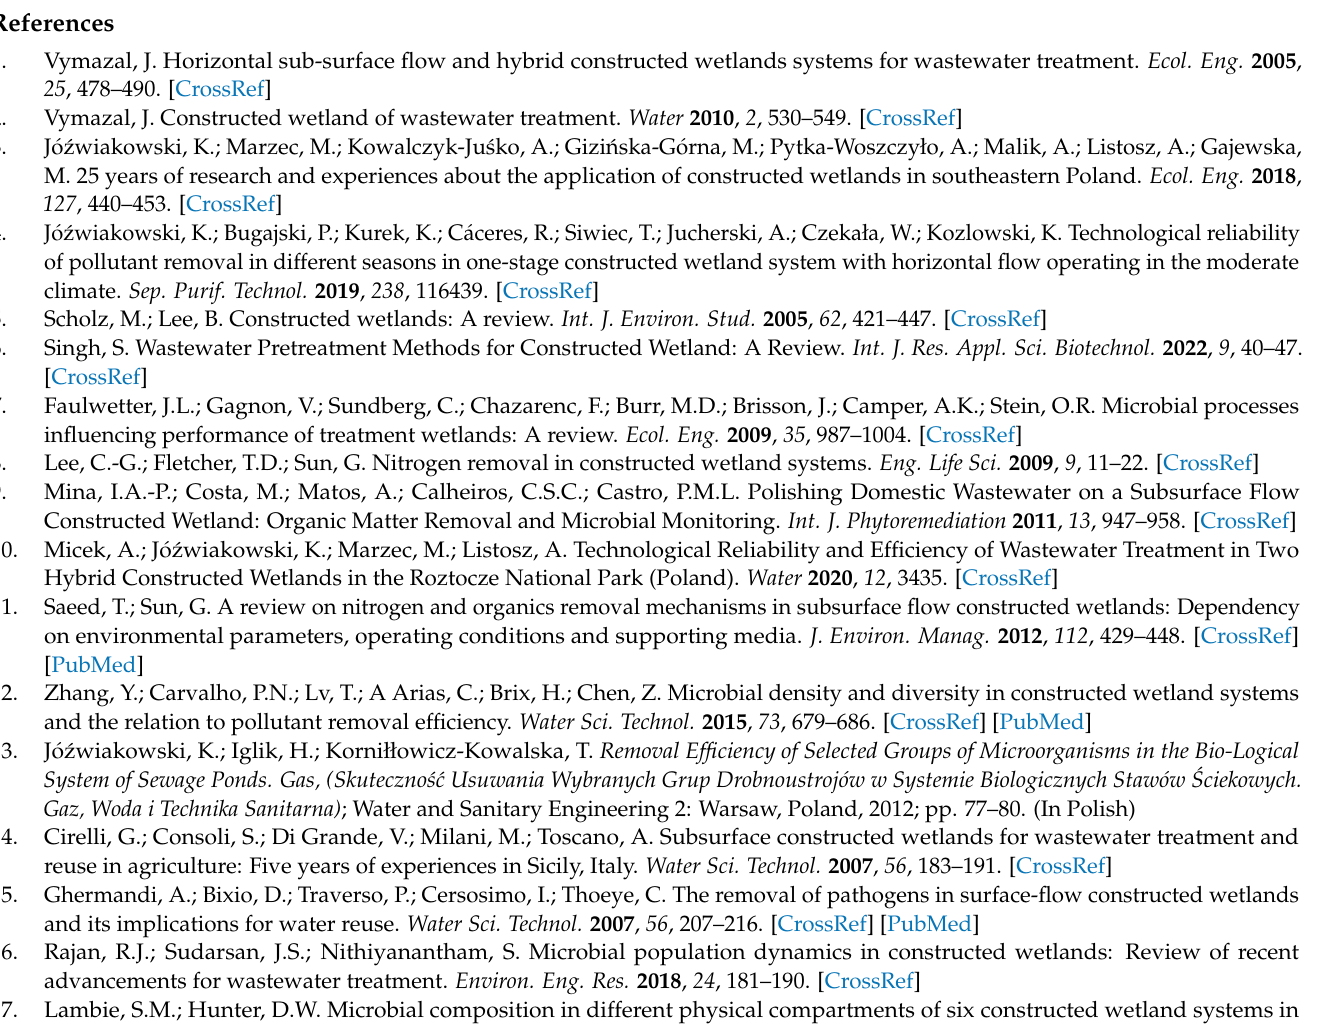
Table S2. Dominance coefficient (D) for the genera of filamentous fungi; I–VI—numbers of wastewater Table S3. Dominance coefficient (D) for the genera of yeasts; explanations as in Table S2: Table S4. Changes in the frequency of the populations of the dominant genera of filamentous fungi at each wastewater treatment